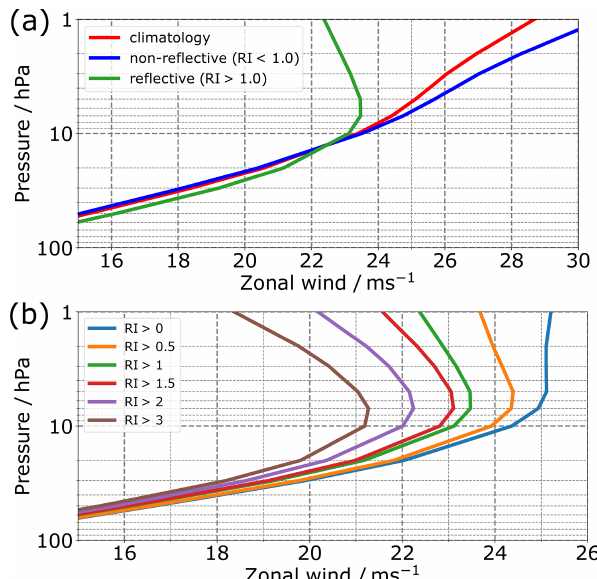
Figure 3. Evolution of the reflection index (grey lines) for the 44 identified reflection events (i.e. RI > 1 for at least 10 consec- utive days) as a function of days from event onset. Lines are dashed where the threshold is not met. The thick red line denotes the av- erage over all events, and the horizontal dashed black line indicates the threshold of RI = 1. Shading indicates a 95% confidence inter- val on the mean assessed as described in Sect.